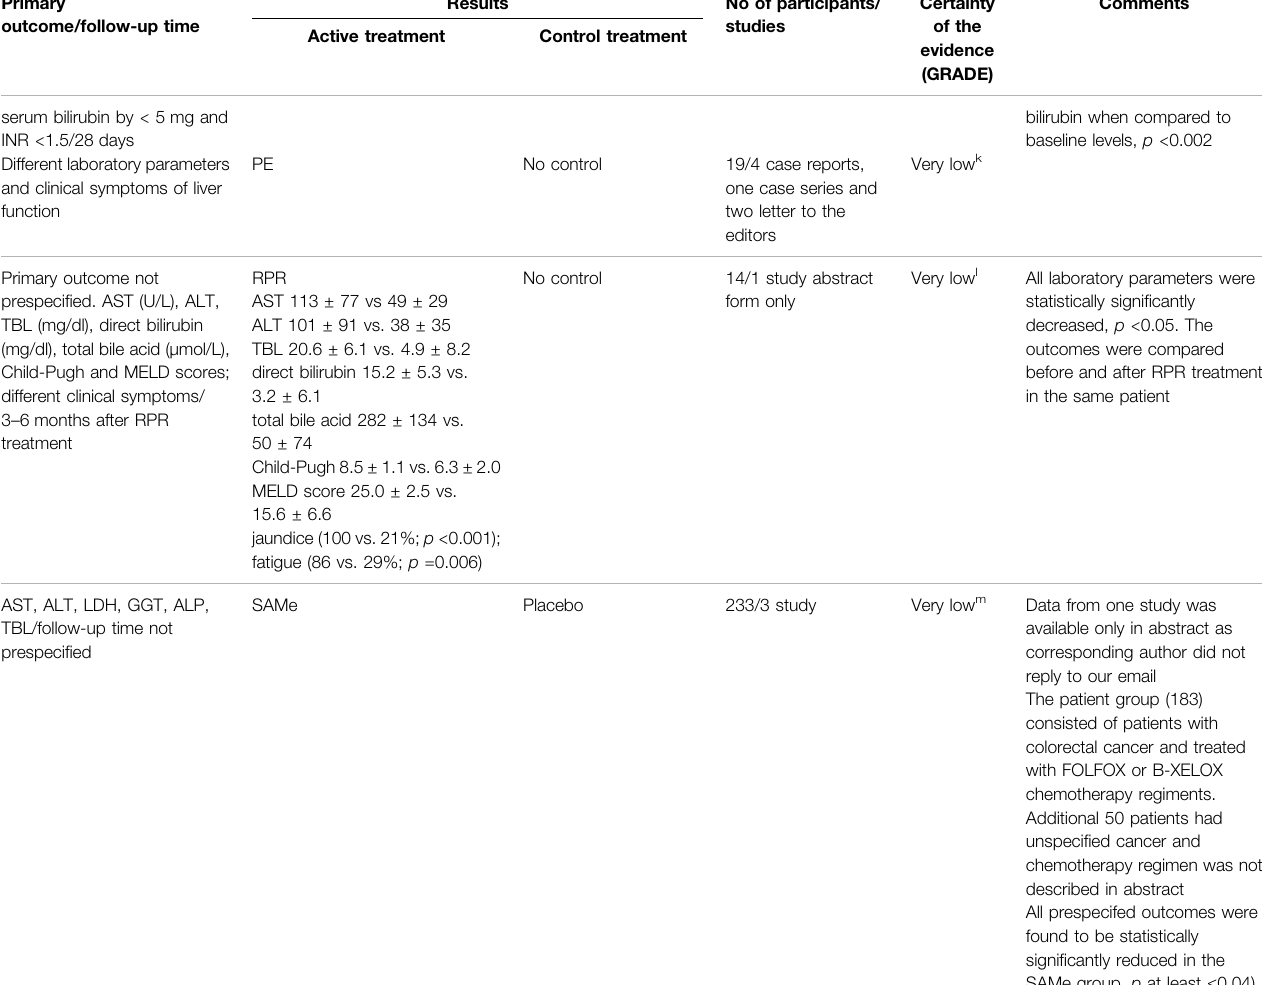
TABLE 4 | ( Continued ) Summary of main outcomes and the certainty of the